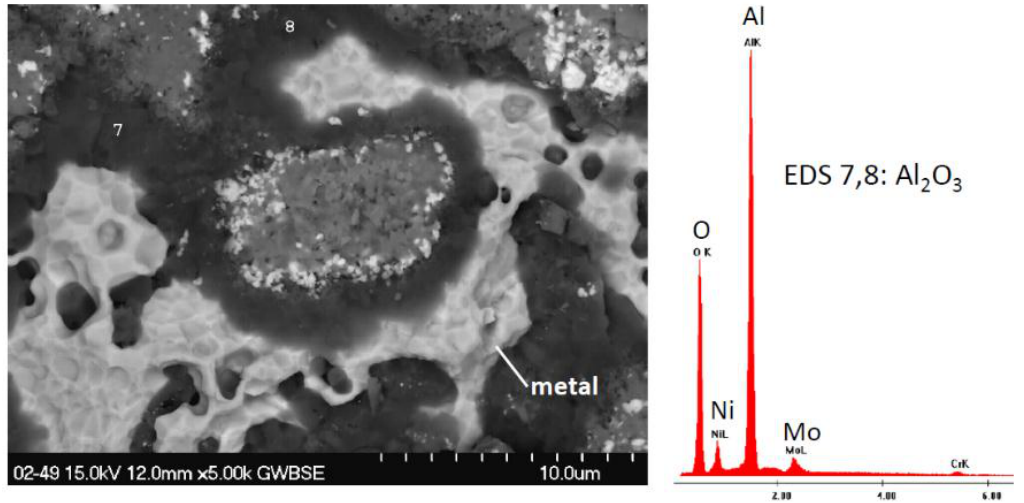
Figure 11. Dark Al 2 O 3 bands and bright exposed metal features on 2-49 alloy (1011). 200 h cyclic oxidation at 1100